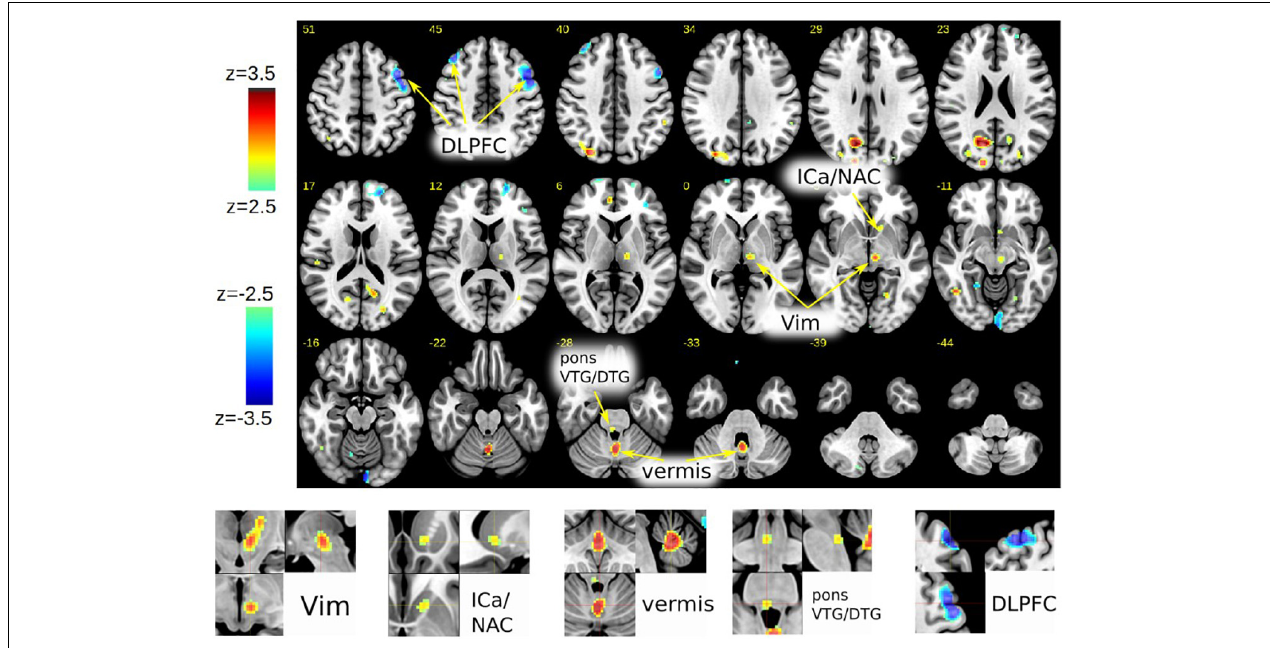
FIGURE 1 | Case #1, FDG-PET activation pattern contrasting DBSon vs. DBSoff. Effects shown are related to initiation of DBS. Pattern description in text. (DLPFC, dorsolateral prefrontal cortex; ICa, anterior limb of internal capsule; NAC, nucleus accumbens; Vim, ventral intermediate nucleus of thalamus; VTG, ventral tegmental nucleus of Gudden; DTG, dorsal tegmental nucleus of